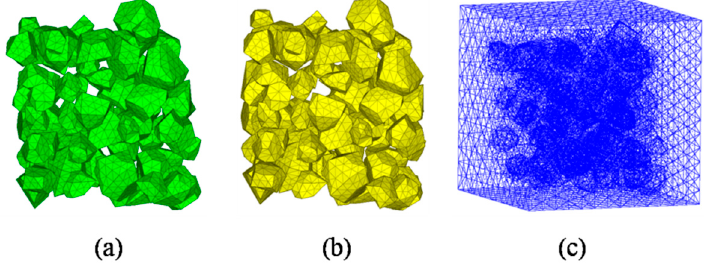
Figure 8. Three-phase mesoscale concrete FE model: ( a ) Aggregate phase, ( b ) ITZ phase, ( c ) mortar phase.